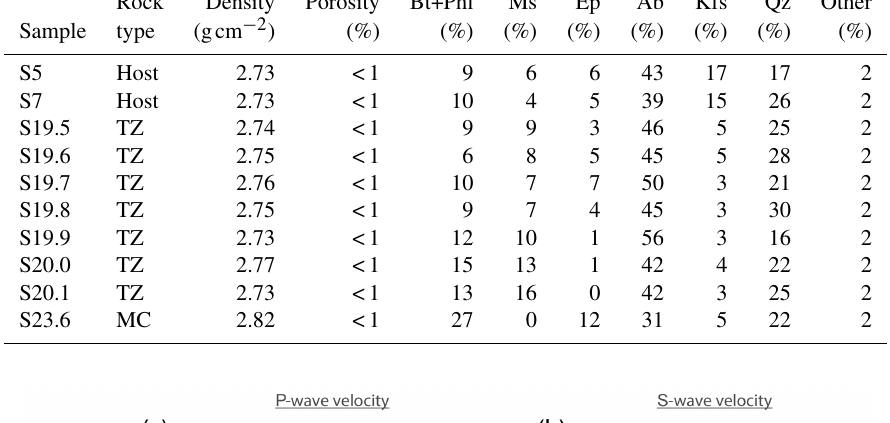
Table 1. Summary of sample composition: sample name refers to depth in the borehole; rock type refers to either the host granodiorite, transition zone (TZ), or mylonitic core (MC); dry bulk density and porosity are reported as an average of individual measurements for each sample ( x 1 and x 3 ); and mineral composition is derived from the QEMSCAN analysis of the x 1 -thin section in % area. Mineral abbreviations: